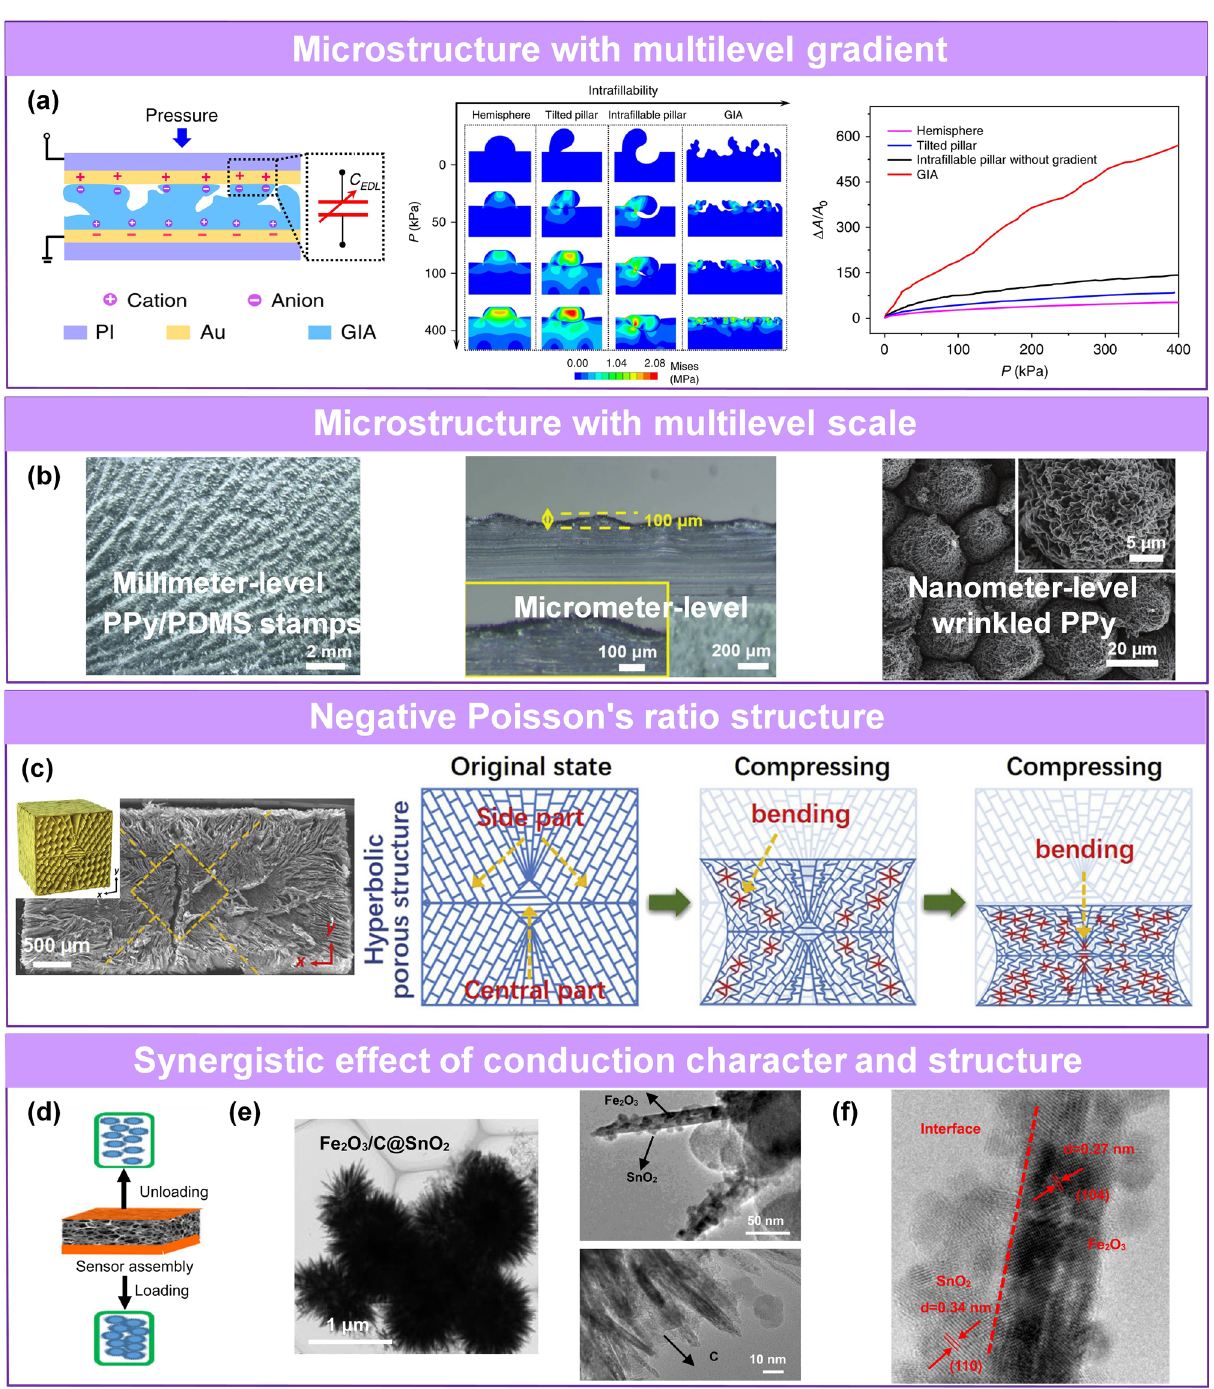
Fig. 7 Pressure sensors with high sensitivity. a Schematic diagram, comparison of compression simulation and sensing performance of graded intrafillable microstructured ultra-capacitive pressure sensor [75]. Copyright (2020) The Authors. b PPy/PDMS stamps with millimeter/micro/ nanostructures [76]. Copyright (2020) Wiley–VCH. c Negative Poisson’s ratio structure with more contact under compression [77]. Copyright (2022) Elsevier. d Pressure sensor based on spongy skeleton combined with sea-urchin shape particles (SUSP). e TEM image and f high-resolu- tion TEM image of heterogeneous interface in SUSP [78]. Copyright (2021) The